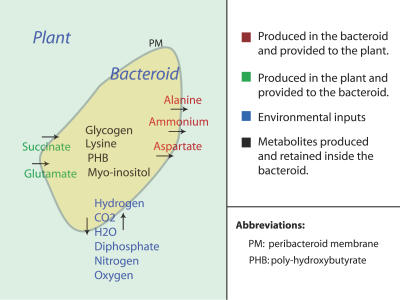
Nutrients Exchanged between Plant and BacteroidFlow of molecules exchanged during symbiosis between plant and bacteroid. PM represents the peribacteroid membrane. The exchange of nutrients includes some amino acids whose evidence has been recently reported [6]. The presence of myo-inositol has been observed, but its source is unknown.